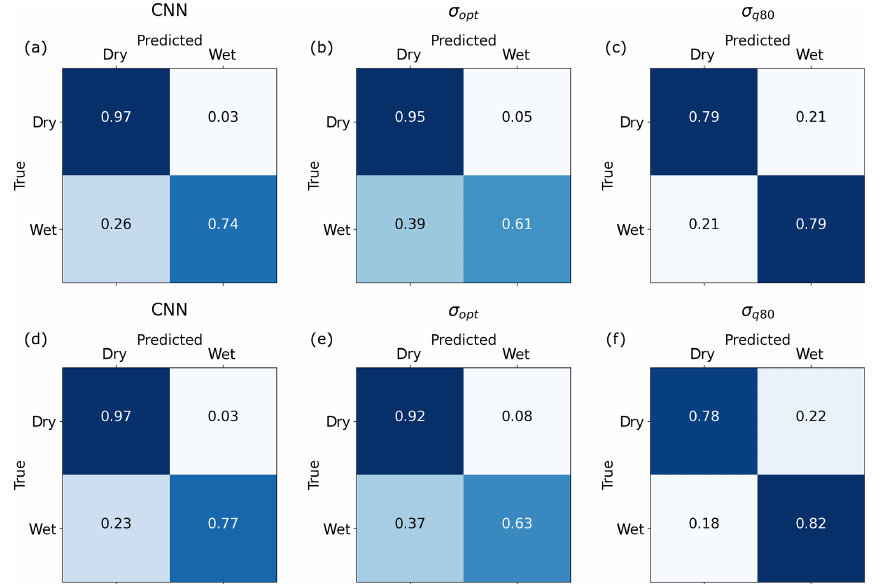
Figure A1. Normalized confusion matrices of VALAPR (a, b, c) and VALSEP (d, e, f) .